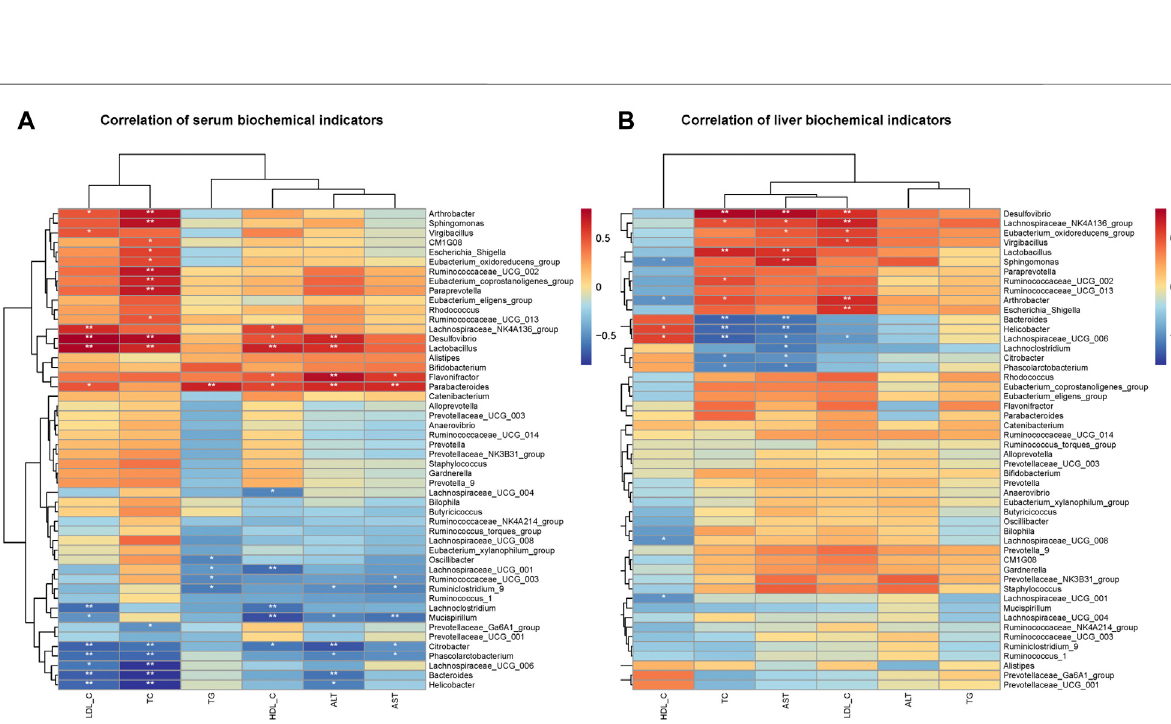
Frontiers in Pharmacology |